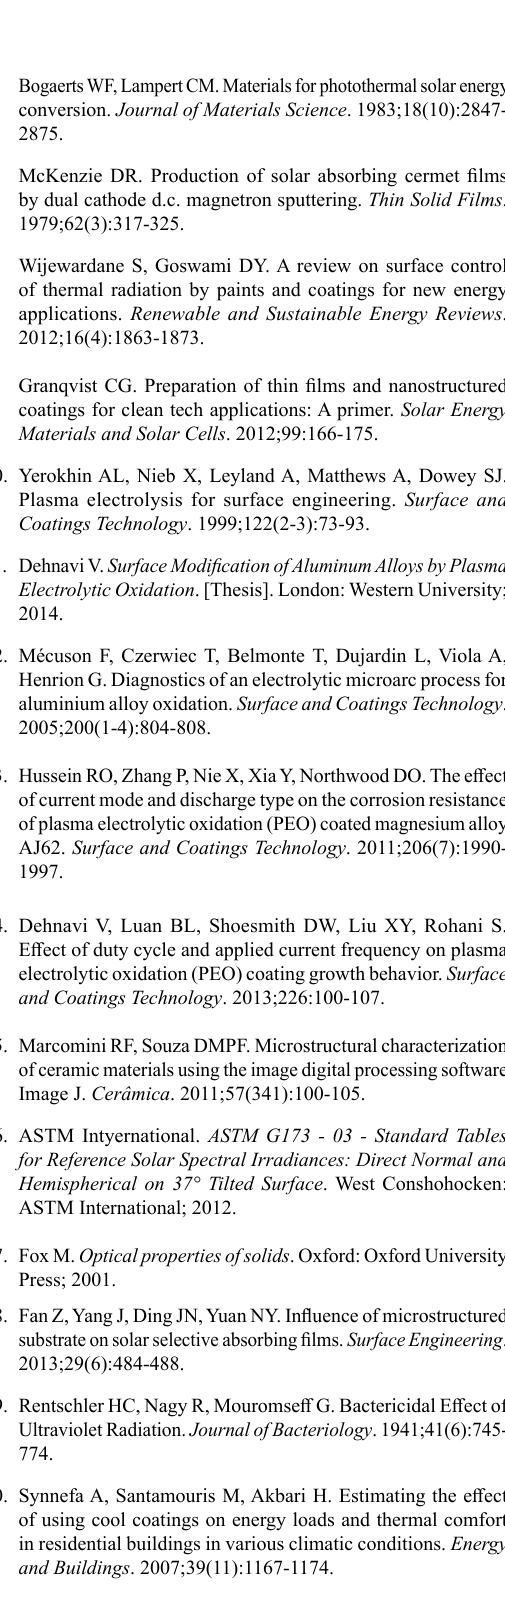
, T 50, 100 100,100